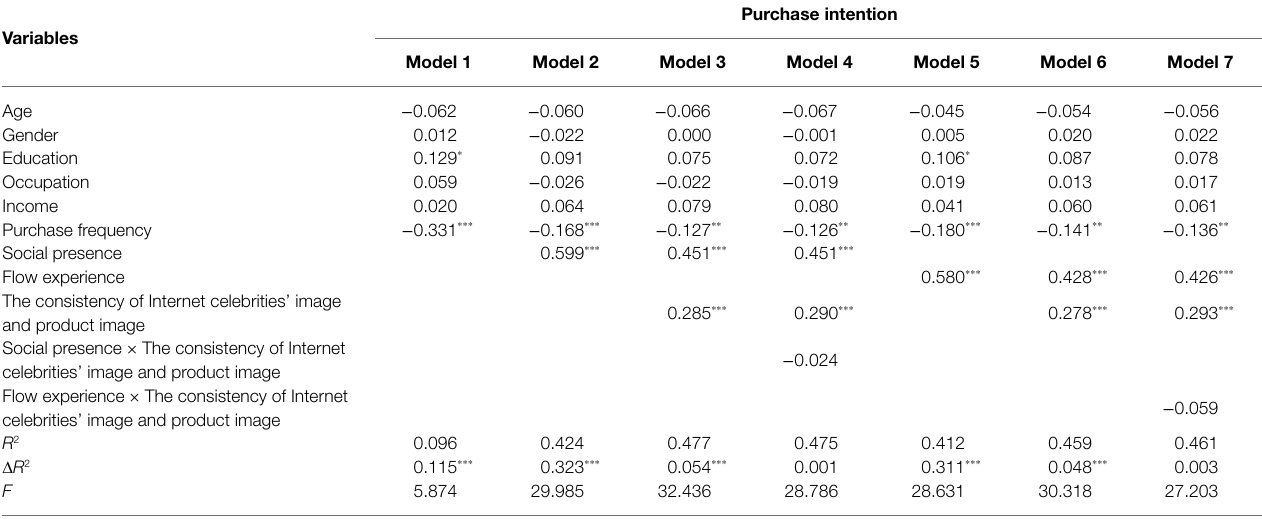
TABLE 3 | Results of the moderated regression